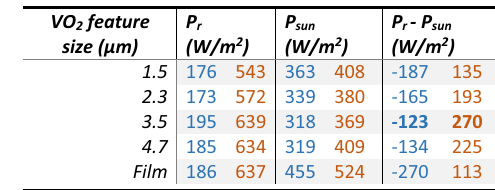
Table  : Calculated performance for radiation cooling in the space environment, at room temperature for VO  in cold (blue,  ° C), and hot (orange,  ° C)